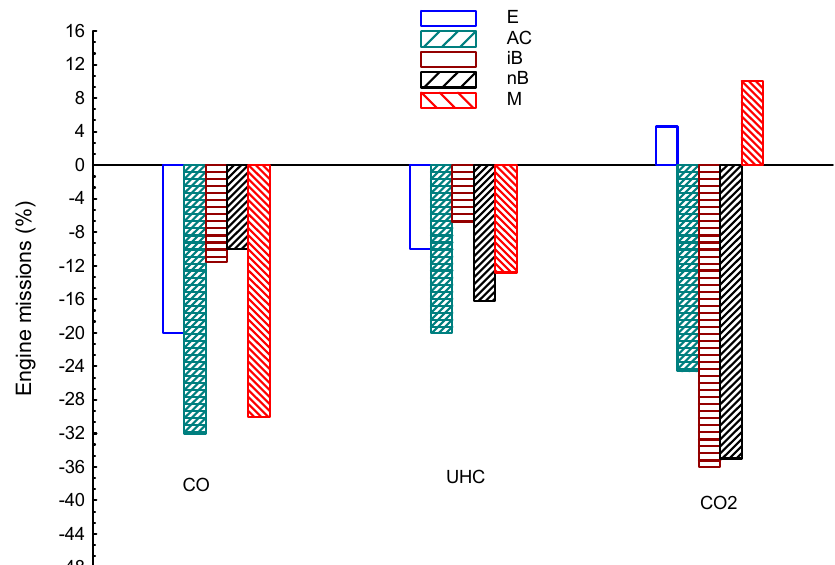
Figure 2. Comparisons of CO, CO 2 , and UHC emissions for ethanol (E), methanol (M), n-butanol (nB), i-butanol (iB) and acetone (AC) blended with gasoline and neat gasoline (baseline) in %.